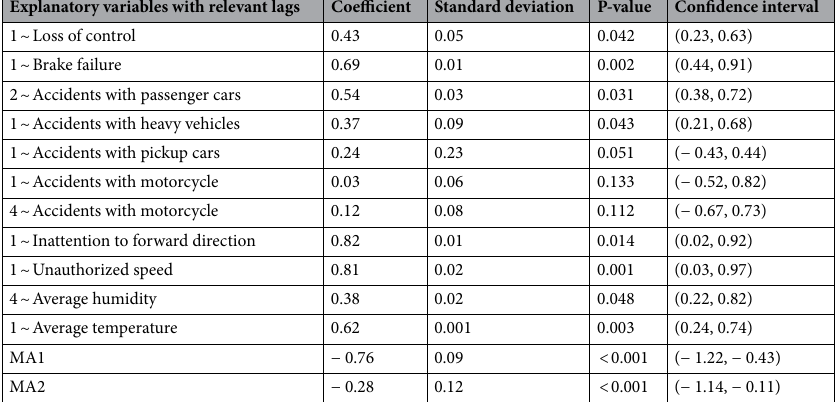
Explanatory variables with relevant